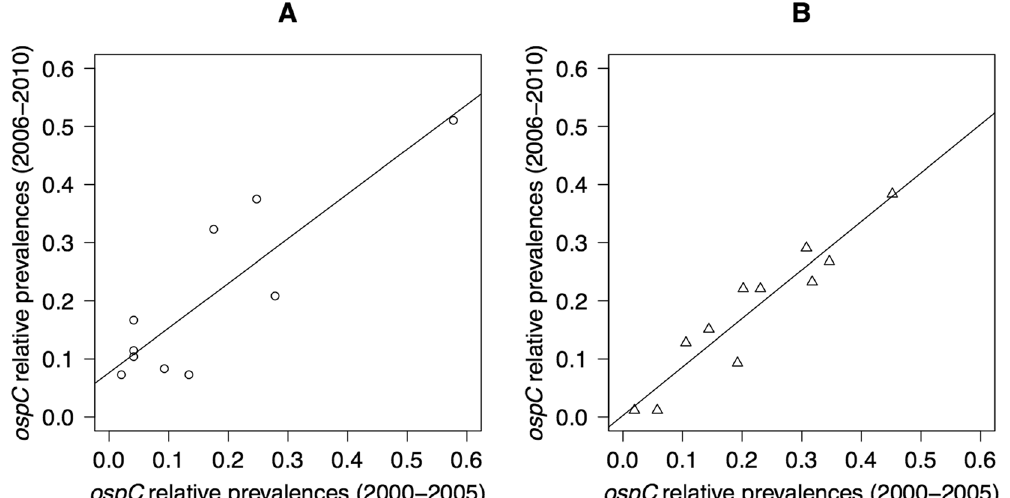
Figure 2. The community of oMG strains is stable over time. The relationship between the relative prevalences of the oMG strains of the first 6 years versus the last 5 years of the survey is shown for both ( A ) B. afzelii and ( B ) B. garinii . The Pearson correlation of the relative prevalence distribution of the oMG strains between the two time periods was highly significant for both Borrelia species. The relative prevalence of an oMG strain is defined as the proportion of B. afzelii -infected nymphs that are infected with that particular oMG